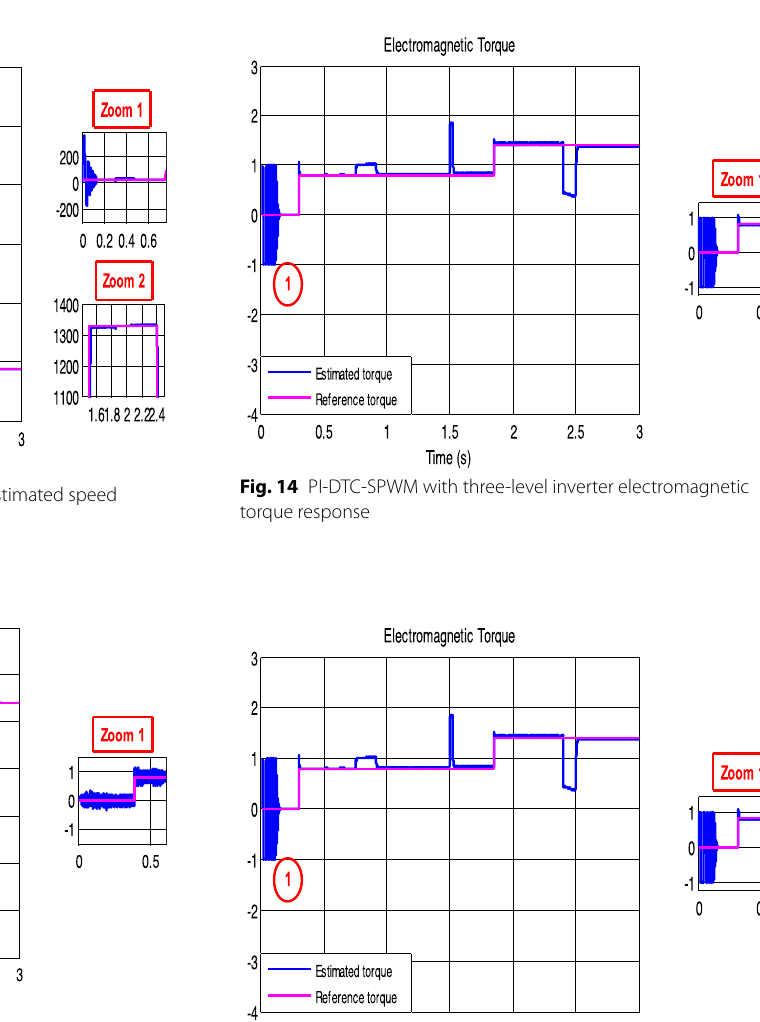
Fig. 13 FL-DTC electromagnetic torque response